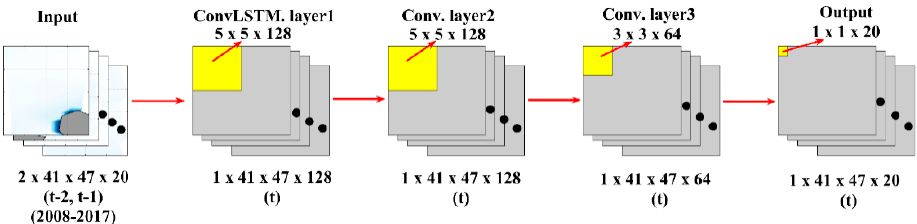
Figure 4. Convolutional long short-term memory network (ConvLSTM) network structure diagram. The meanings of each color in this figure are the same as those in Figure 3.